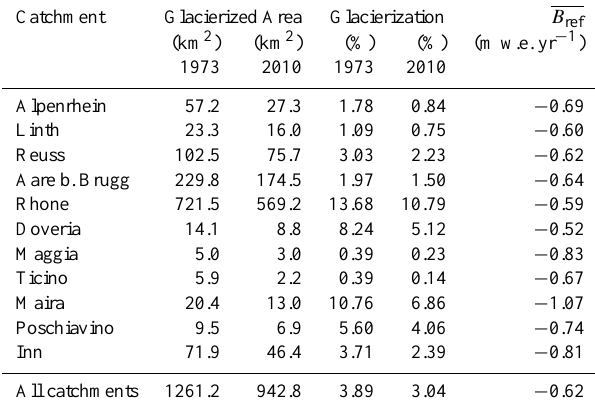
Table 1. Mean geodetic mass balance 1980–2010 for the main hy- drological catchments of Switzerland shown in Fig. 8, listed in al- phabetic